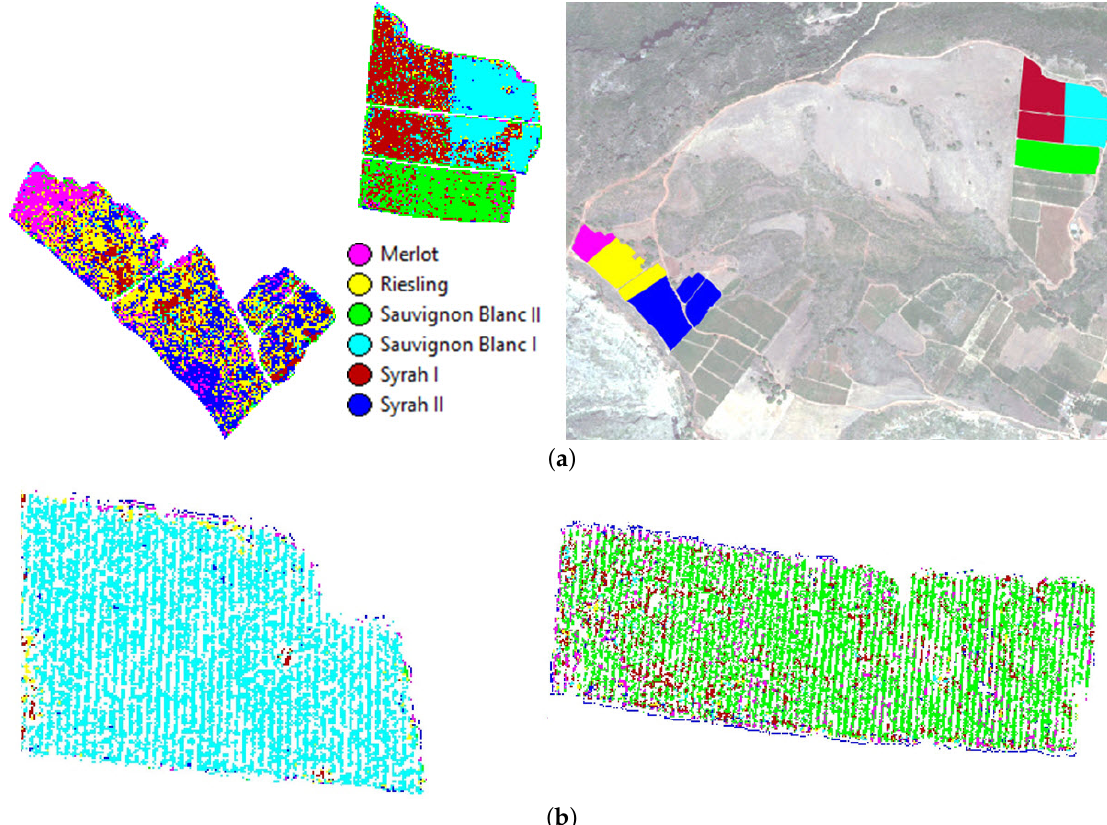
Figure 5. Experimental results from the supervised classification in the Trapeza study area for the discrimination of six different varieties. The overall classification accuracy at the pixel level (first processing step) was just above 60%, while after the majority voting (second processing step), the OA reached 100% at the parcel level (Table 4). ( a ) The resulting classification map based on the multispectral data (2-m resolution, left) and the ground truth data (right); ( b ) the resulting classification map based on the detected canopy (pan-sharpened data at 50-cm resolution) for vine parcels with Sauvignon Blanc Clone I (left) and Sauvignon Blanc Clone II